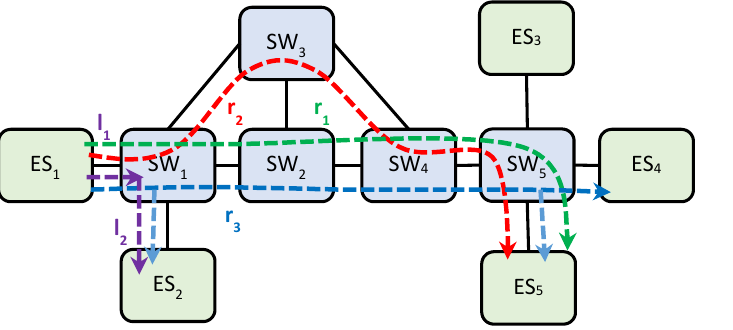
Figure 1. Example of a simple time-sensitive network (TSN) architecture: TSN components, unicast and multicast transmission, and alternative routes.